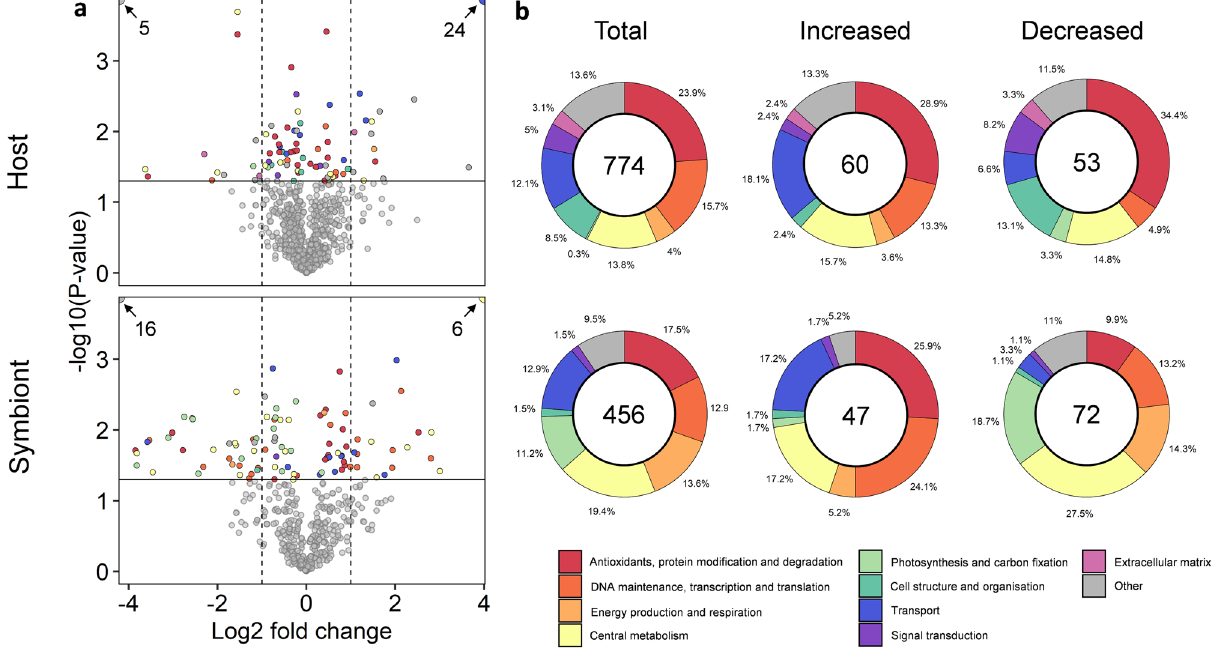
Figure 3. Overview of proteomic analyses: ( a ) Funnel plot of log2 fold change vs −log10 p -value of detected proteins and ( b ) total number and proportional changes in differentially expressed proteins grouped at the level of biological and molecular function (GO-term classification) for the host and symbiont proteomes in response to elevated temperature. Vertical dashed lines indicate a log2 fold-change of 1, solid horizontal line indicates significance value (−log10 p -value < 0.05). Numbers inside circles indicate abundance of total and differentially expressed proteins detected in host and symbiont. Colours indicate functional grouping of